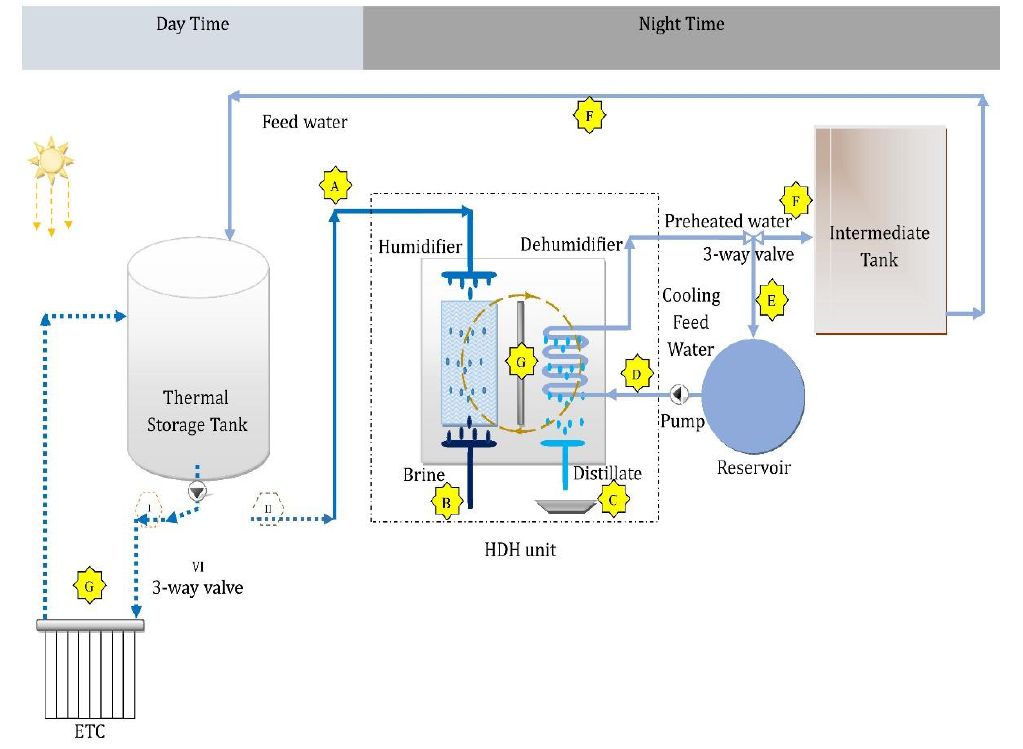
Figure 2. Overall system labelled with key modelling